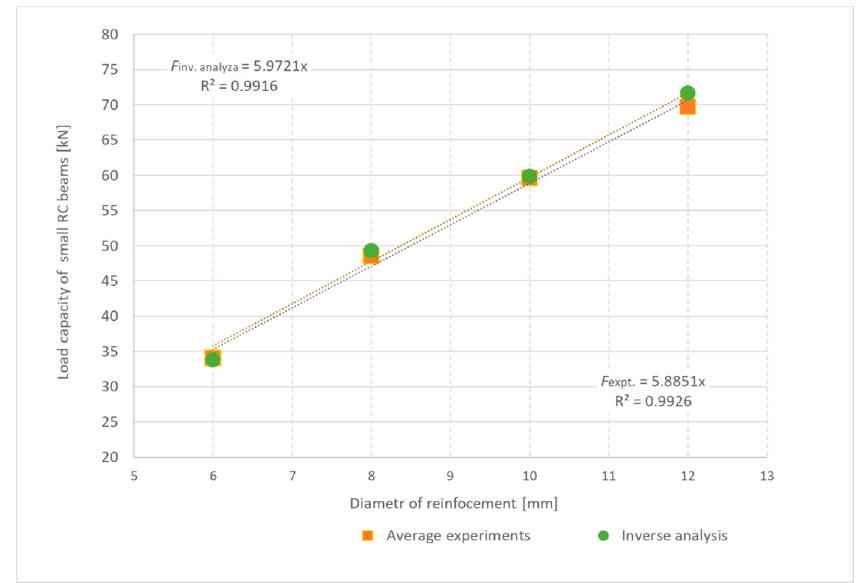
Figure 9. Load capacity of small reinforced concrete beams without transverse reinforcement: Experiments and inverse analysis results shown.